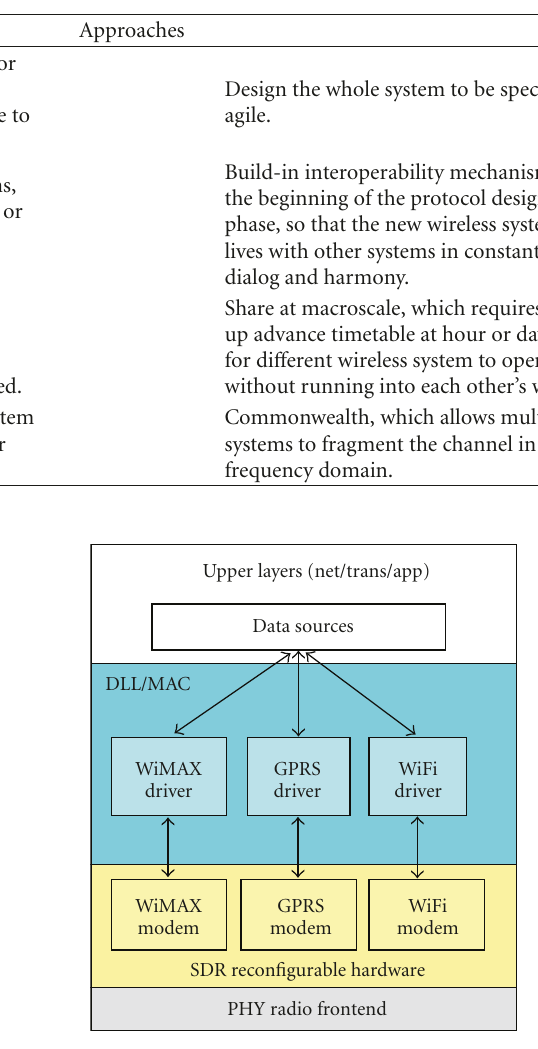
Figure 3: The base station software/hardware architecture for spectrum access scheduling based on SDR (Software Defined